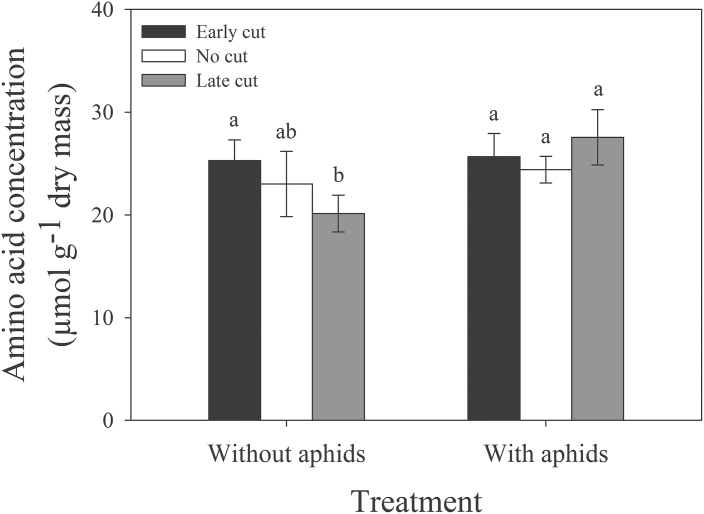
Effects of plant-damage treatment on total foliar amino acid concentrations. Mean values (± SEs) are shown. Bars with the same letters were not significantly different (P<0.05).